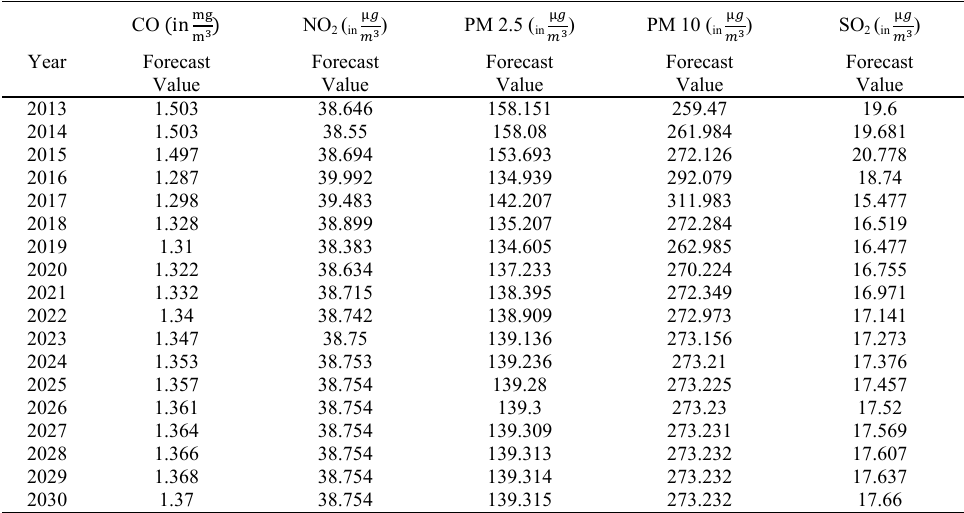
Table 3: Annual concentration of pollutants forecasted by ARIMA (1,1,1) of Varanasi up to the year 2030 CO Year Forecast Forecast Forecast Forecast Forecast Value Value Value Value Value 2013